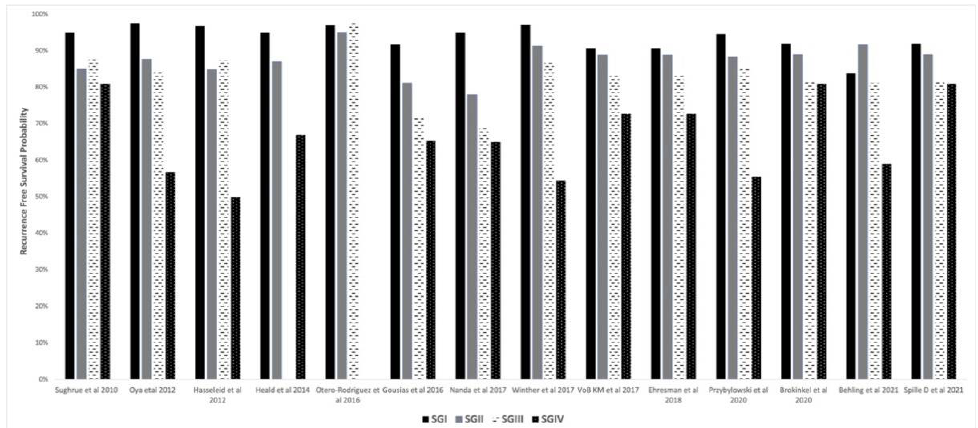
Figure 1. Bar Diagram demonstrating Recurrence-Free Survival Probabilities based on Simpson Grade reported in the literature.